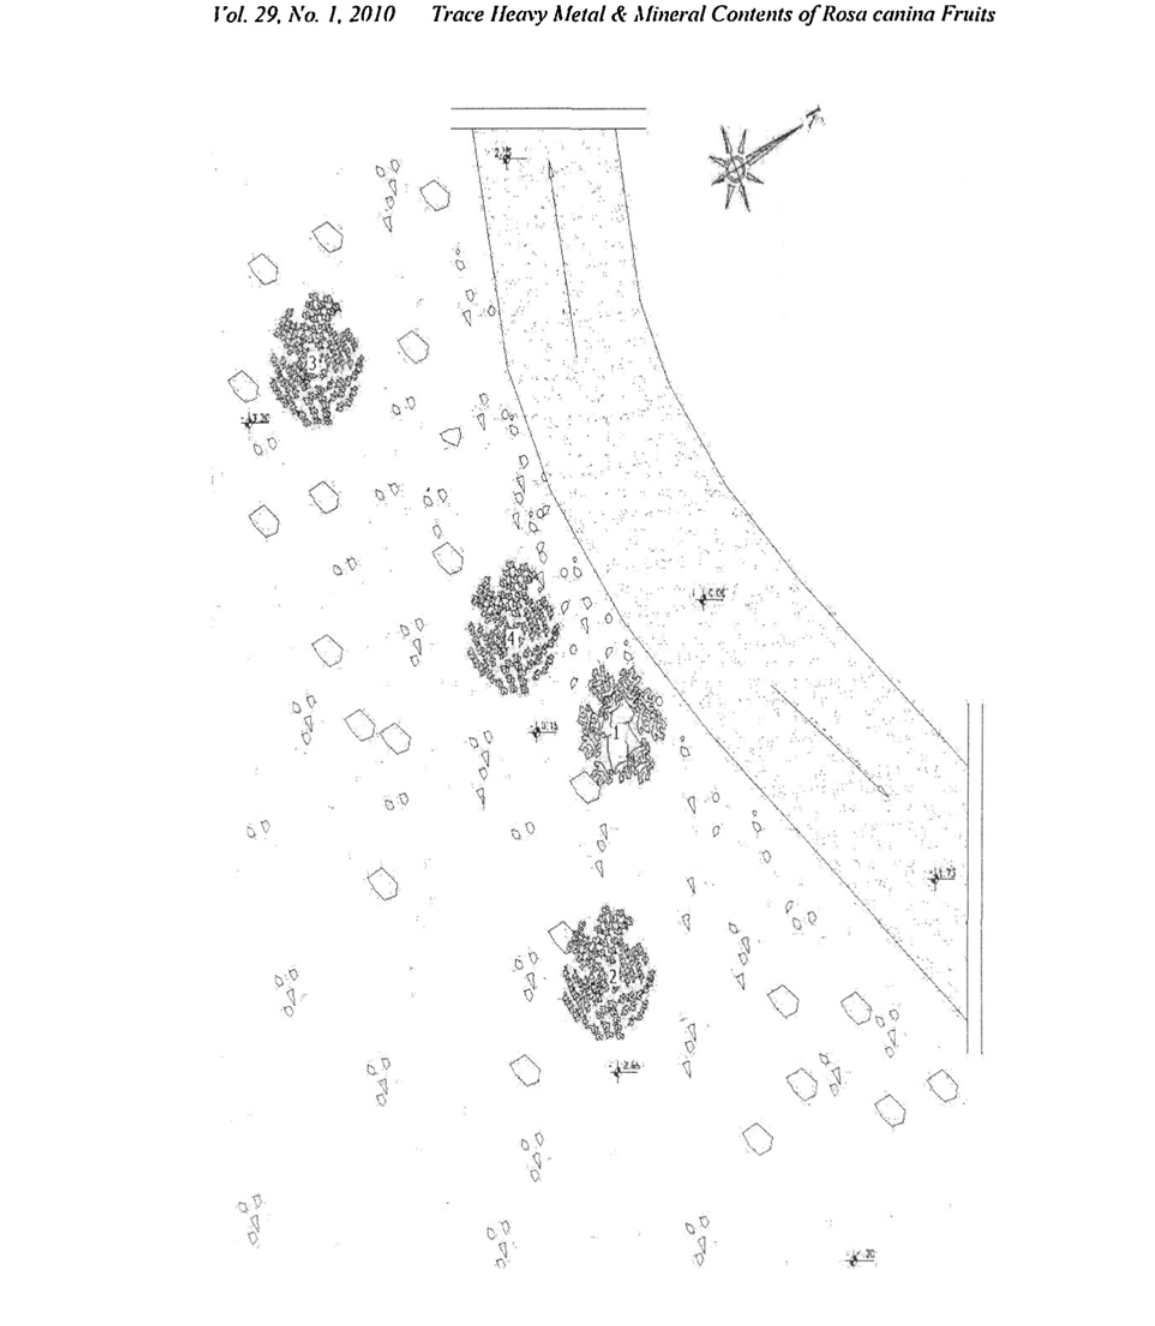
Fig. 1:. Sites of collections of Rosa canina L